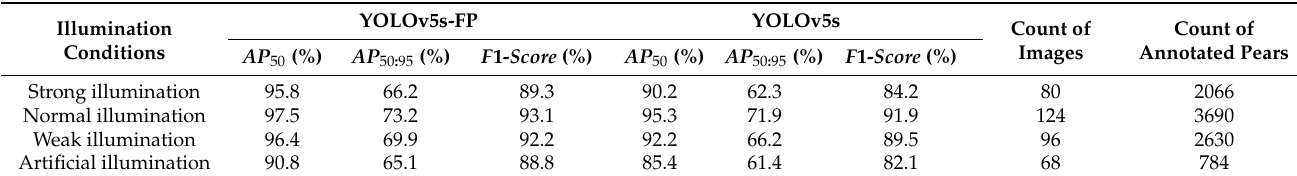
Table 6. Detection accuracy of two networks under different illumination conditions.